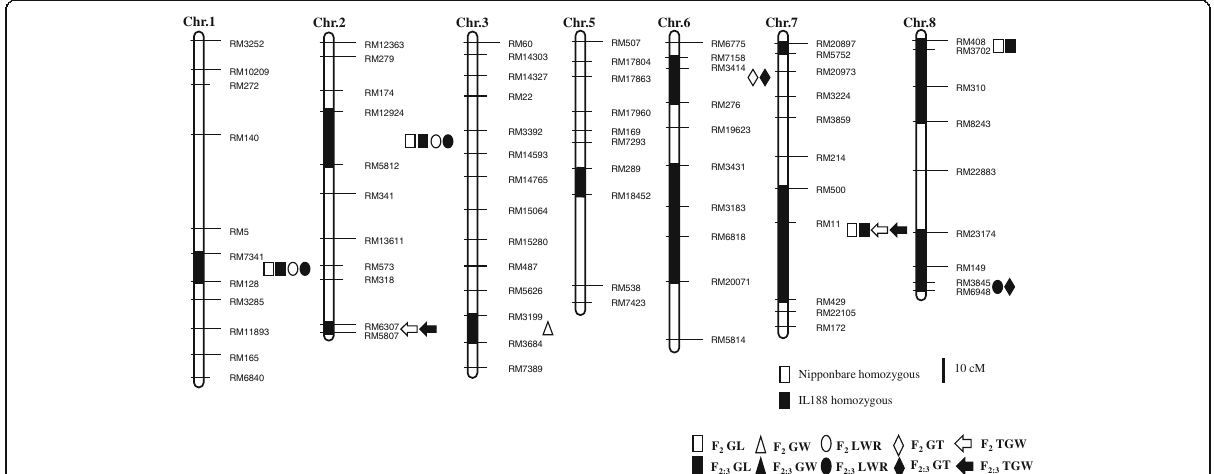
Fig. 2 Genetic linkage map showing QTL positions detected in the F 2 and F 2:3 populations. White and black shapes indicate F 2 and F 2:3 population, respectively